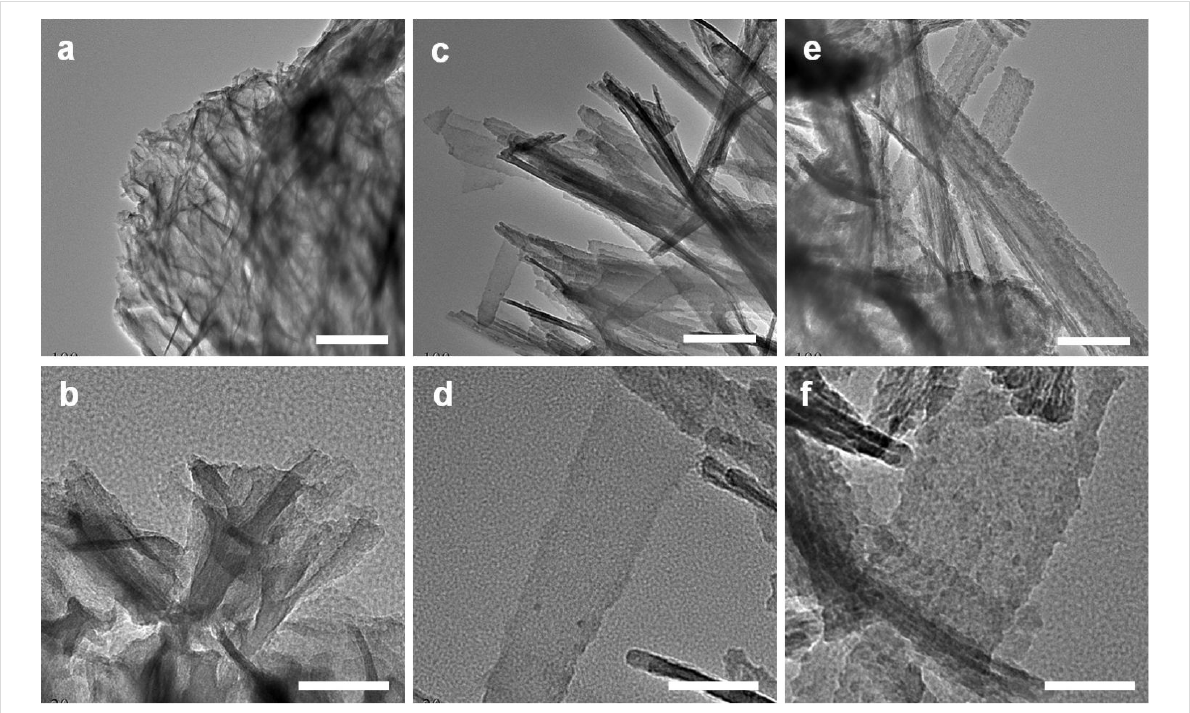
Figure 3: TEM images of LPEI@silica nanograss surface prepared from silica sources corresponding to the mixtures of 15 mL IPA, 15 mL water and 0.5 mL MS51 (a and b); 30 mL water and 0.5 mL MS51 (c and d); and 30 mL water and 0.5 mL TMOS (e and f). The LPEI matrix was formed from 5.0 wt % LPEI in water, and the silica deposition was performed for 40 min at room temperature. The scale bars are 200 nm (a, c and e) and 50 nm (b, d and